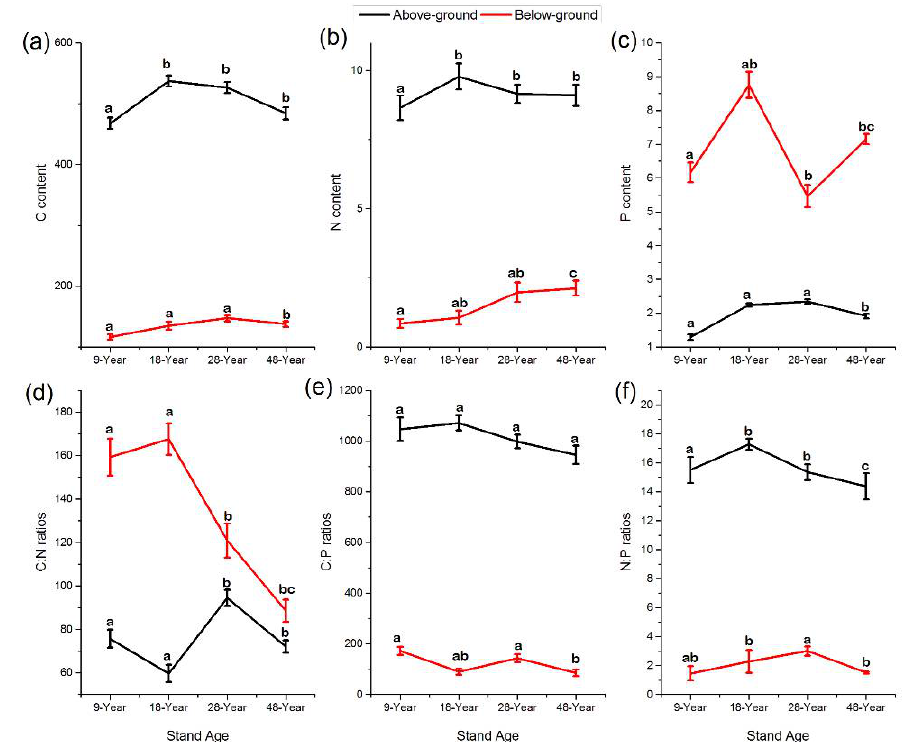
Figure 4. Pattern of aboveground and belowground component C, N, P stoichiometry Masson pine chronosequence. Error bars show standard error while the lines represent mean value with three replicates ( n = 3), whereas the lower-case letters ( a – c ) represent the three among the stand age ( p < 0.05). ( d – f ) shows ratios of C, N and P in the above and belowground